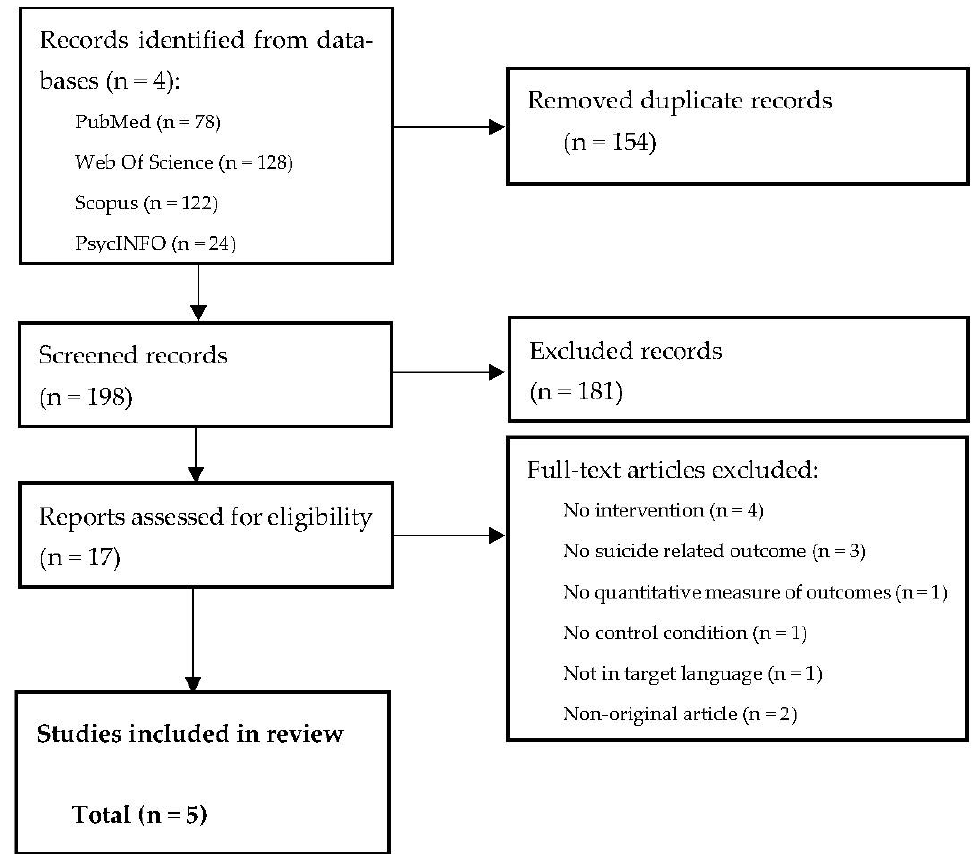
Figure 1. PRISMA flowchart of the study selection process.